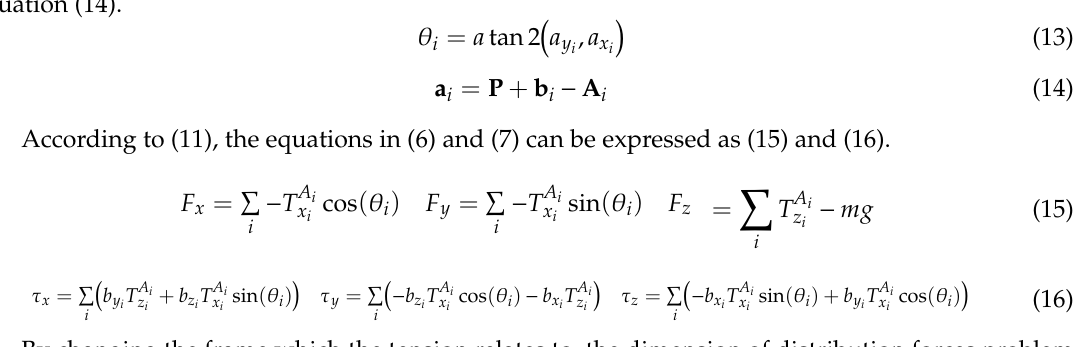
Figure 2. General geometric model of cable-driven parallel manipulators